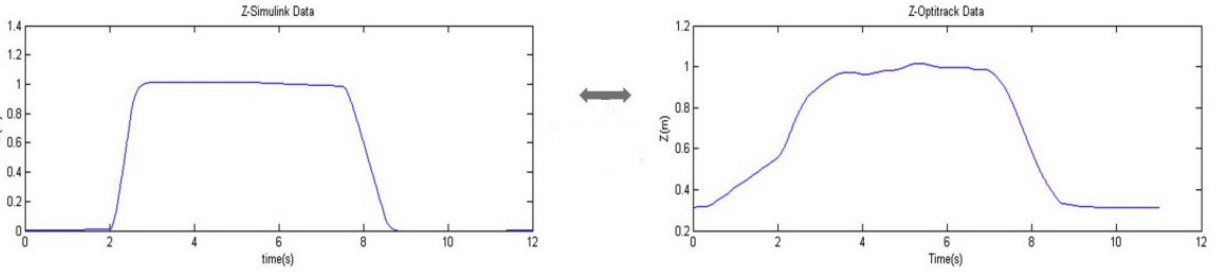
Figure 62. Flight trajectory of the second flapping wing prototype using Optitrack. Left: Intended flight path simulation; Right: Actual flight path captured by